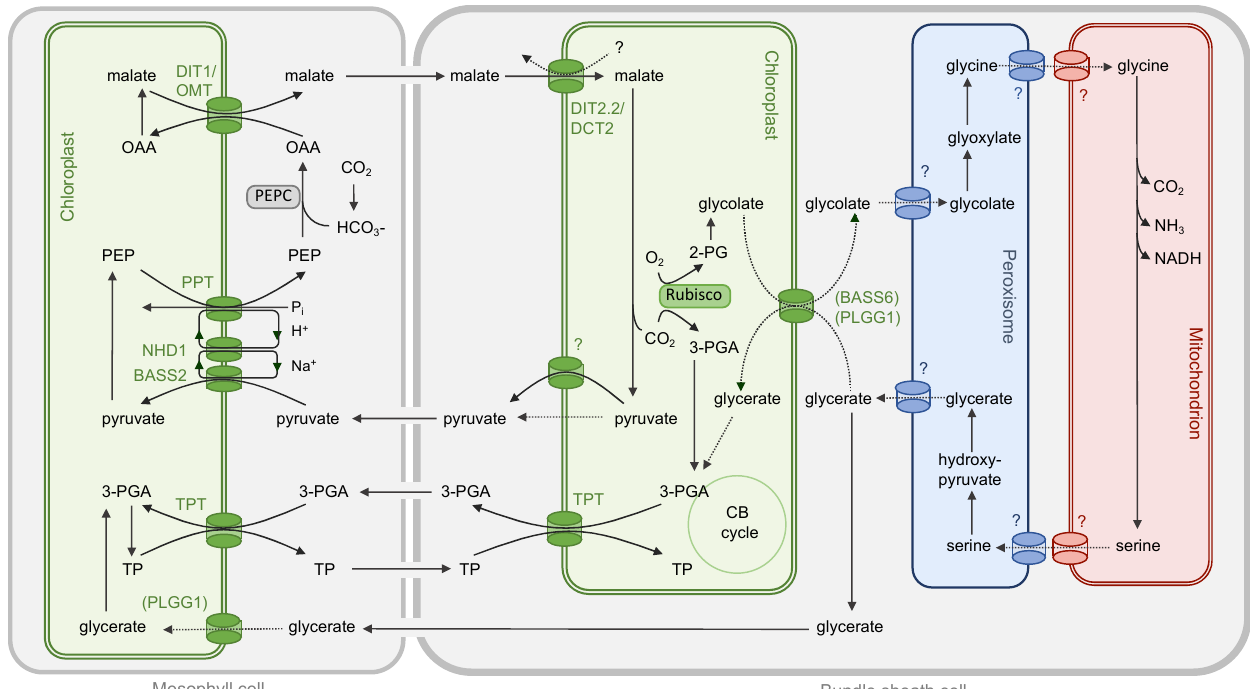
Figure 3. Transport steps in the NADP-ME subtype of C 4 photosynthesis including CB cycle and PR. The minor C 4 aspartate shuttle has been omitted. The CO 2 -fixing enzymes in the two cell types are shown in boxes, and the names of the transporters are shown in the color of the associated organelle. The transporters responsible for cell specific exchange of PR metabolites have not been confirmed experimentally and are shown in brackets. Metabolite transport mechanisms without experimental evidence are shown in dashed lines.